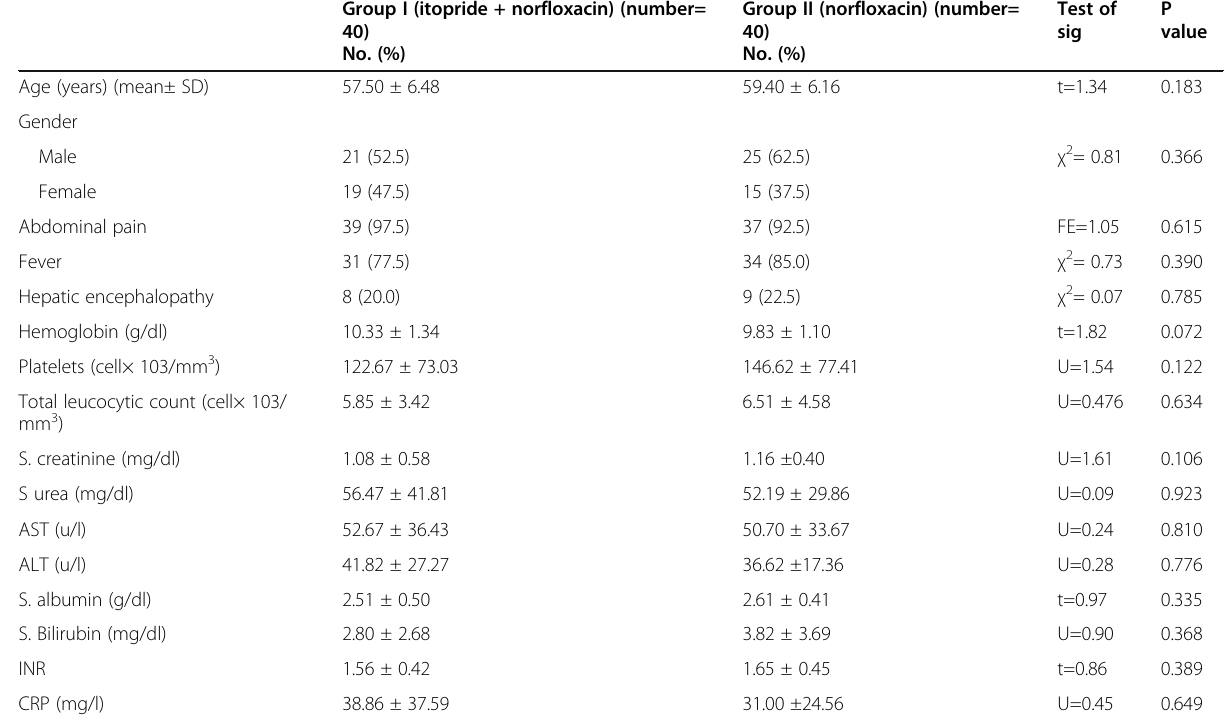
Table 1 Baseline demographic data, clinical manifestations, and the laboratory investigations of both groups Group I (itopride + norfloxacin) (number= 40)